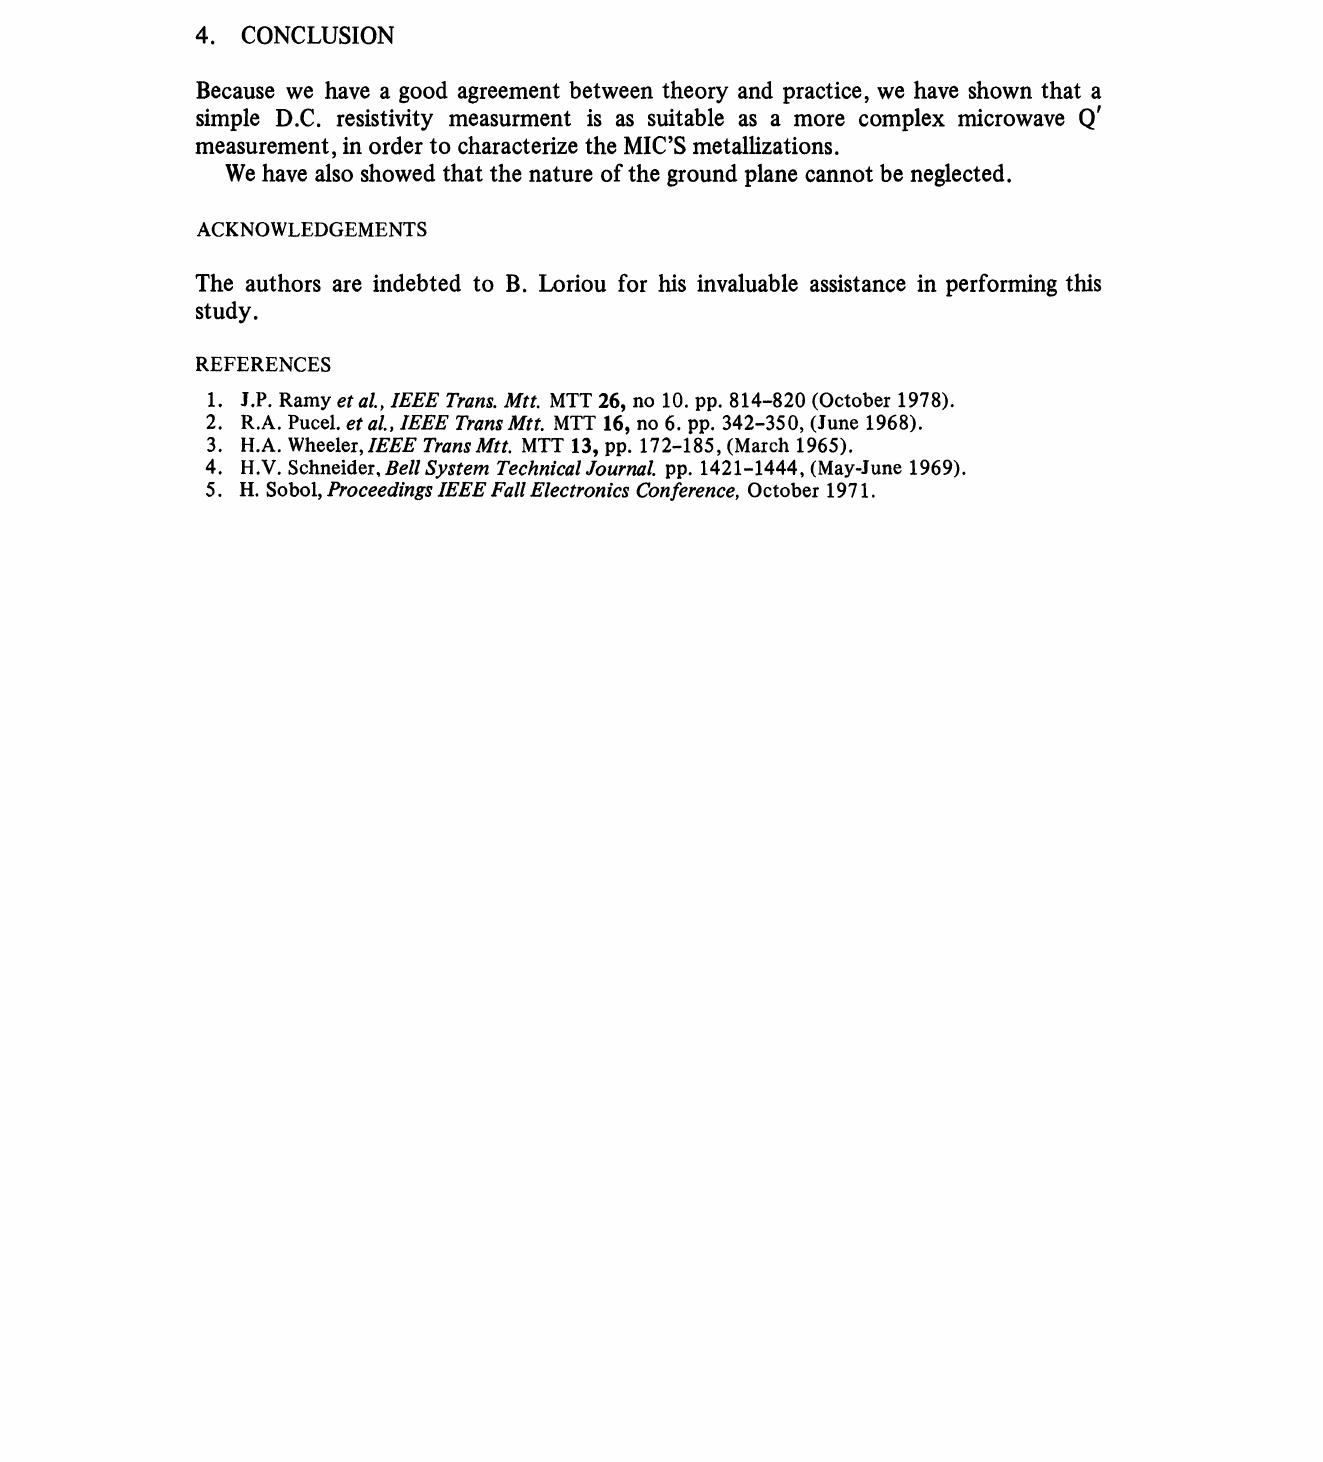
Theoretical and experimental effect of ground plane metallization on Q. For t D, G and L values, see tables II and III;